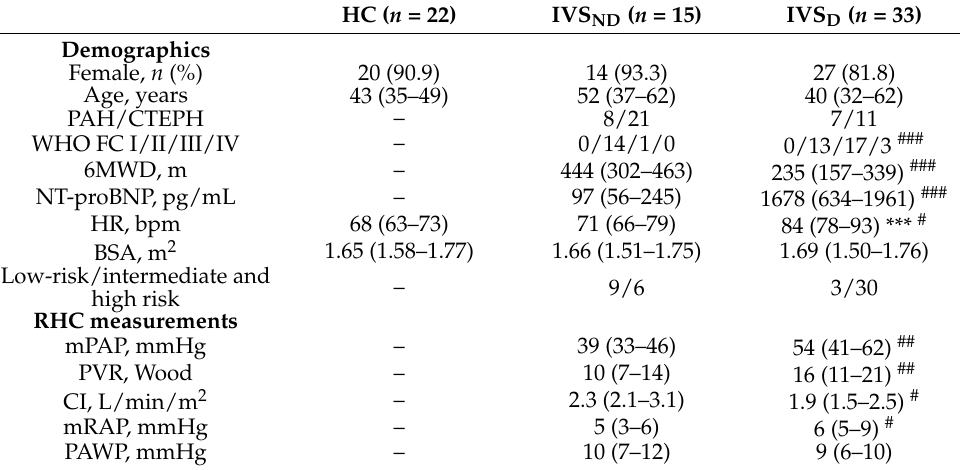
Table 1. Demographic, clinical and RHC characteristics in the health control and PH